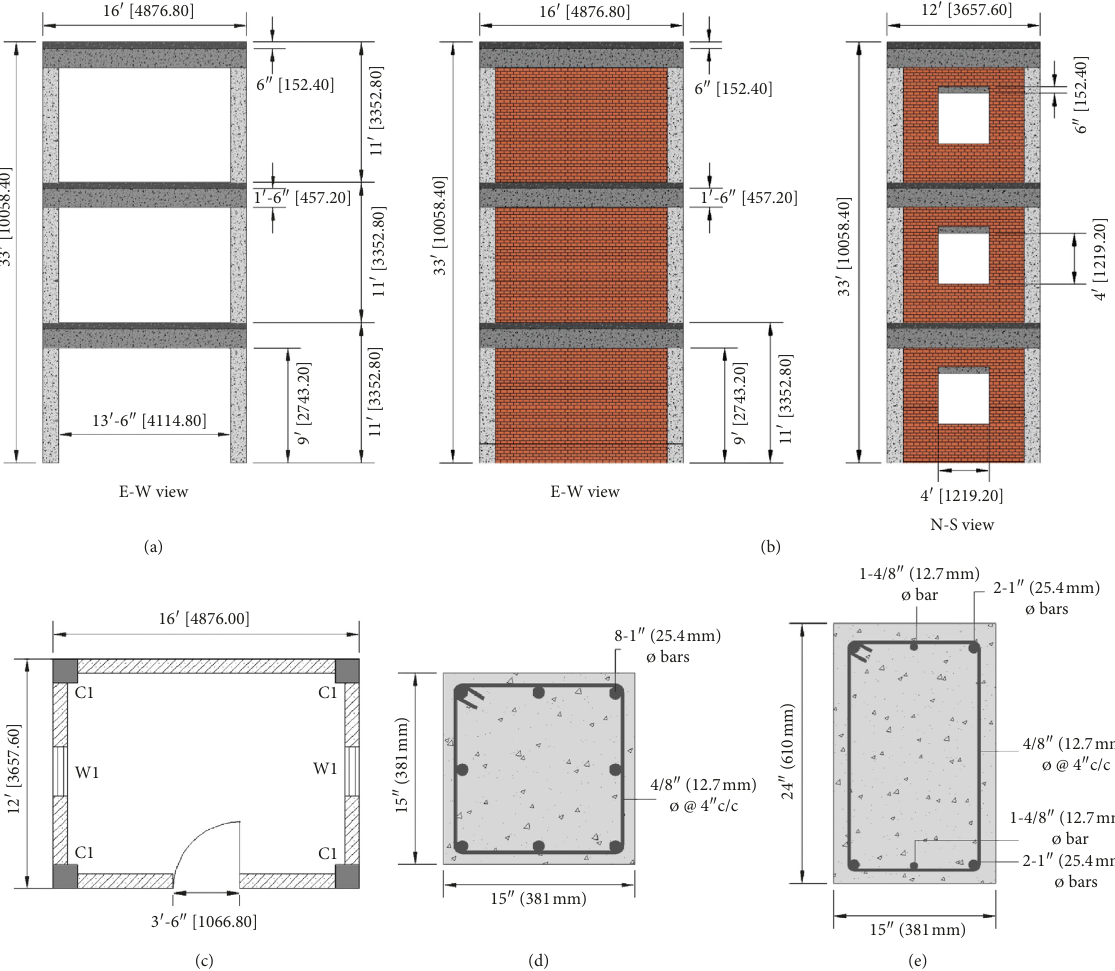
Figure 1: Geometric and reinforcement details of the prototype frames. The dimensions in brackets are given in mm. (a) RC bare frame (b) Masonry-infilled RC frame. (c) Plane view. (d) Column X -section. (e) Beam X -section.